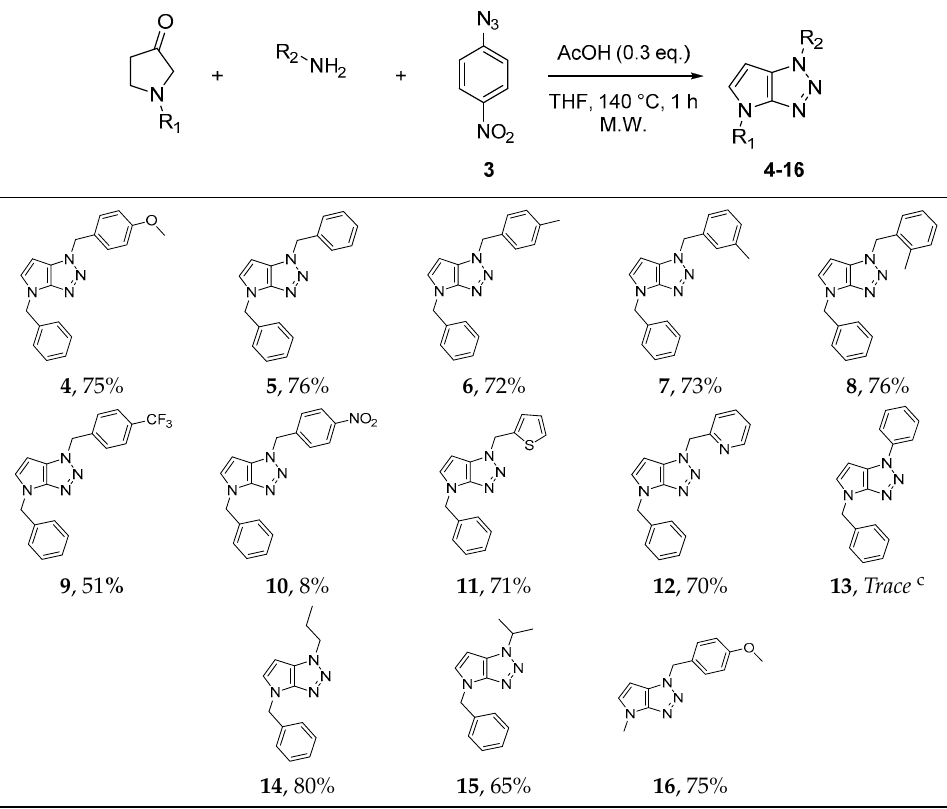
Table 2. Scope of the MCR reaction: synthesis of 4 – 16 a,b . Table 2. Scope of the MCR reaction: s ynthesis of 4 – 16 a,b . Table 2. Scope of the MCR reaction: s ynthesis of 4 – 16 a,b . Table 2. Scope of the MCR reaction: s ynthesis of 4 – 16 a,b . Table 2. Scope of the MCR reaction: s ynthesis of 4 – 16 a,b . Table 2. Scope of the MCR reaction: s ynthesis of 4 – 16 a,b . Table 2. Scope of the MCR reaction: s ynthesis of 4 – 16 a,b . Table 2. Scope of the MCR reaction: s ynthesis of 4 – 16 a,b . Table 2. Scope of the MCR reaction: s ynthesis of 4 – 16 a,b . Table 2. Scope of the MCR reaction: s ynthesis of 4 – 16 a,b . Table 2. Scope of the MCR reaction: s ynthesis of 4 – 16 a,b . Table 2. Scope of the MCR reaction: s ynthesis of 4 – 16 a,b . Table 2. Scope of the MCR reaction: s ynthesis of 4 – 16 a,b . Table 2. Scope of the MCR reaction: s ynthesis of 4 – 16 a,b . Table 2. Scope of the MCR reaction: s ynthesis of 4 – 16 a,b